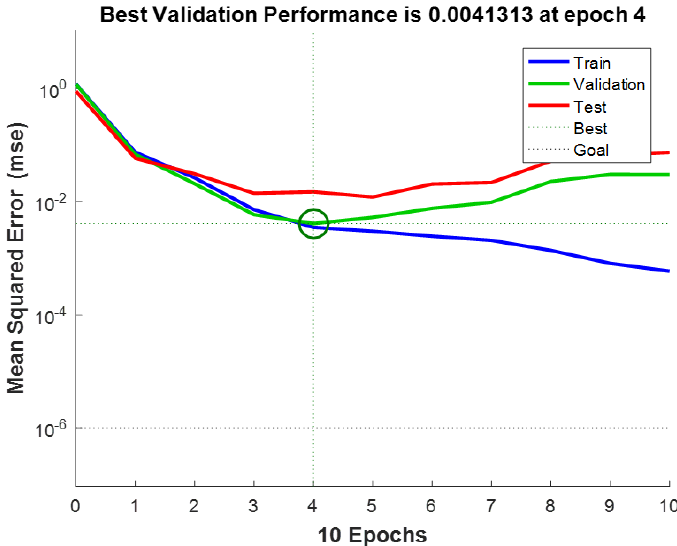
Figure 28. The mean square error graph. The gradient parameter curve indicates the gradient change in the error surface, and the parameter mu indicates the adjustment range of the weight error. As can be seen in Figure 29, the error gradient decreases continuously with the increase in training generations. It reaches 0.00389 at the tenth generation, while the weight error reaches 10 − 5 . The training is stopped after the error has reached the initially set adjustment